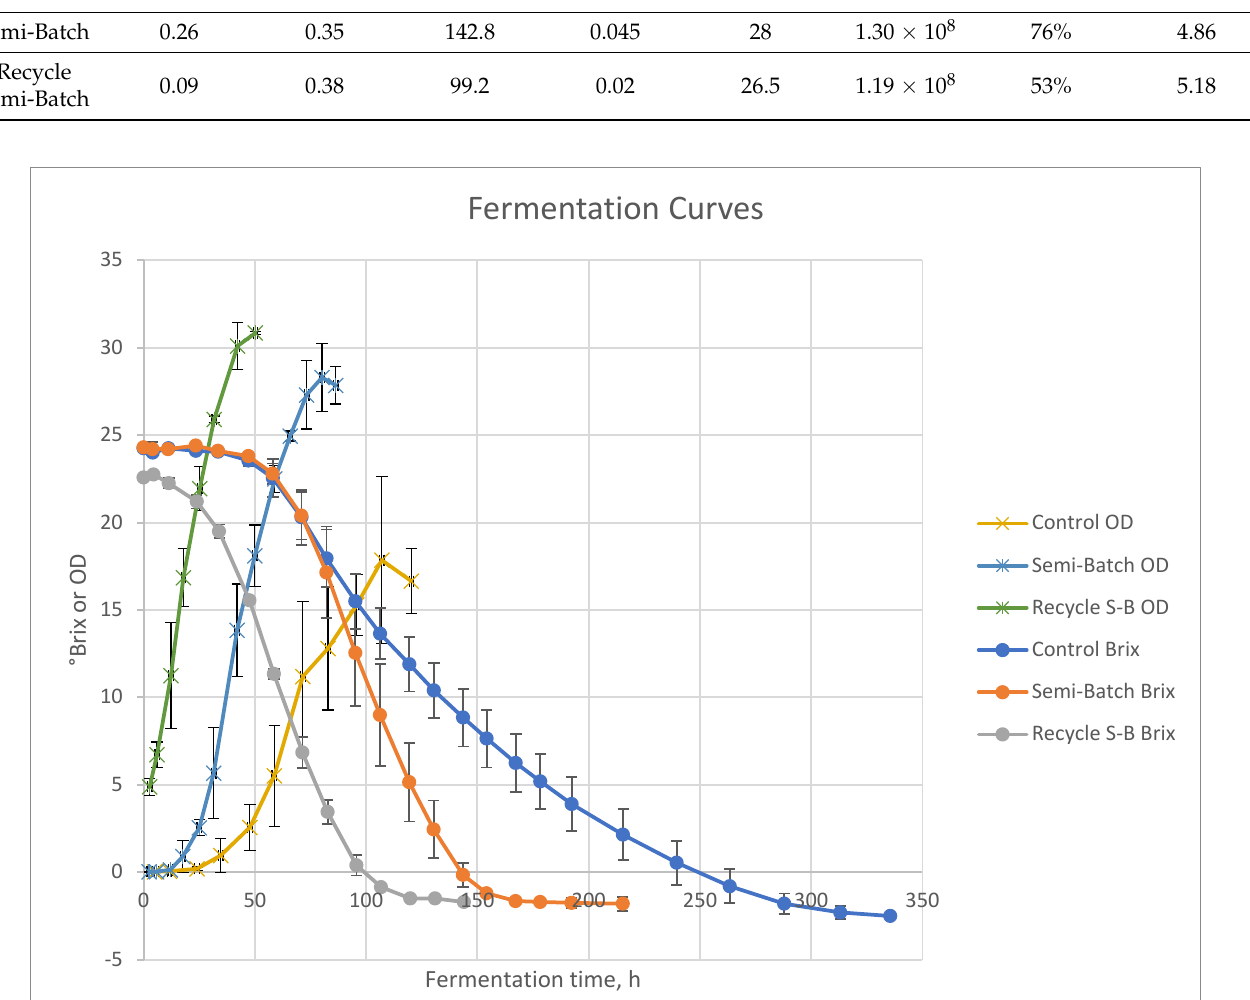
Figure 2. Fermentation curves showing Brix and Optical Density of the control, Semi-Batch (S-B), and Recycle-Semi-Batch (Recycle S-B) fermentations. The 95% confidence intervals are shown. The control slowly reaches a lower peak biomass compared to the intensified processes. The recycle-semi-batch starts at a much higher initial optical density due to the recycled inoculum. Substantial fermentation cycle time improvements are gained via the intensified processes. Table 2. Pilot fermentation kinetics.